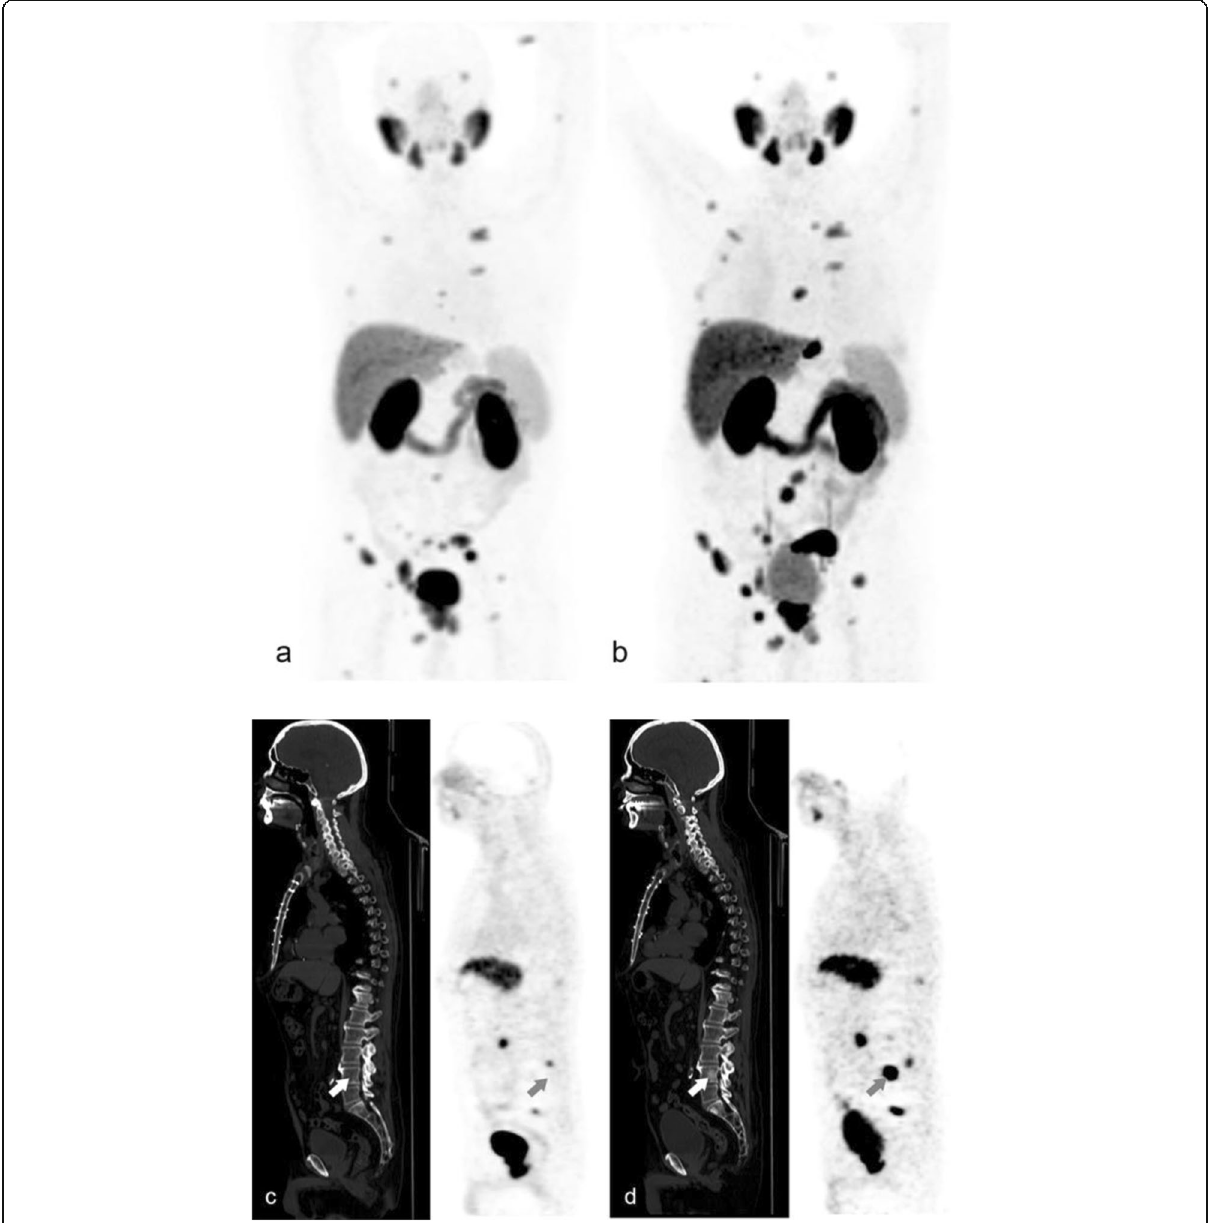
Fig. 2 A 77-year-old patient with PCa, Gleason score 9, and PSA 13.5 ng/ml. a [ 68 Ga]Ga-PSMA-11 PET/CT performed for staging showed extensive local disease as well as metastatic disease to pelvic lymph nodes and numerous skeletal metastases. b PSA levels declined by 25% to 10.8 ng/ml after 4.5months of treatment with abiraterone (biochemical stable disease). Follow-up PET/CT showed stable disease in soft tissue, however, marked progression was noted in bone, with more extensive known lesions as well as new lesions. Imaging response was categorized as “ progressive-disease. ” The arrows in c and d indicate an example of a new PSMA-avid sclerotic bone lesion. This patient was continued on the same treatment and had marked progression on a recent follow-up PET as well as elevation of serum PSA to